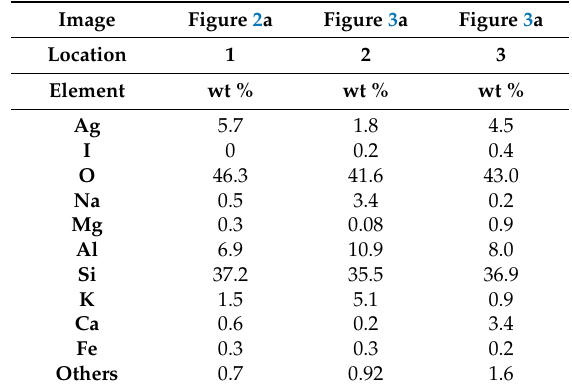
Table 3. Composition of the features highlighted in the SEM images in Figures 2a and 3a determined with EDS spot analysis.